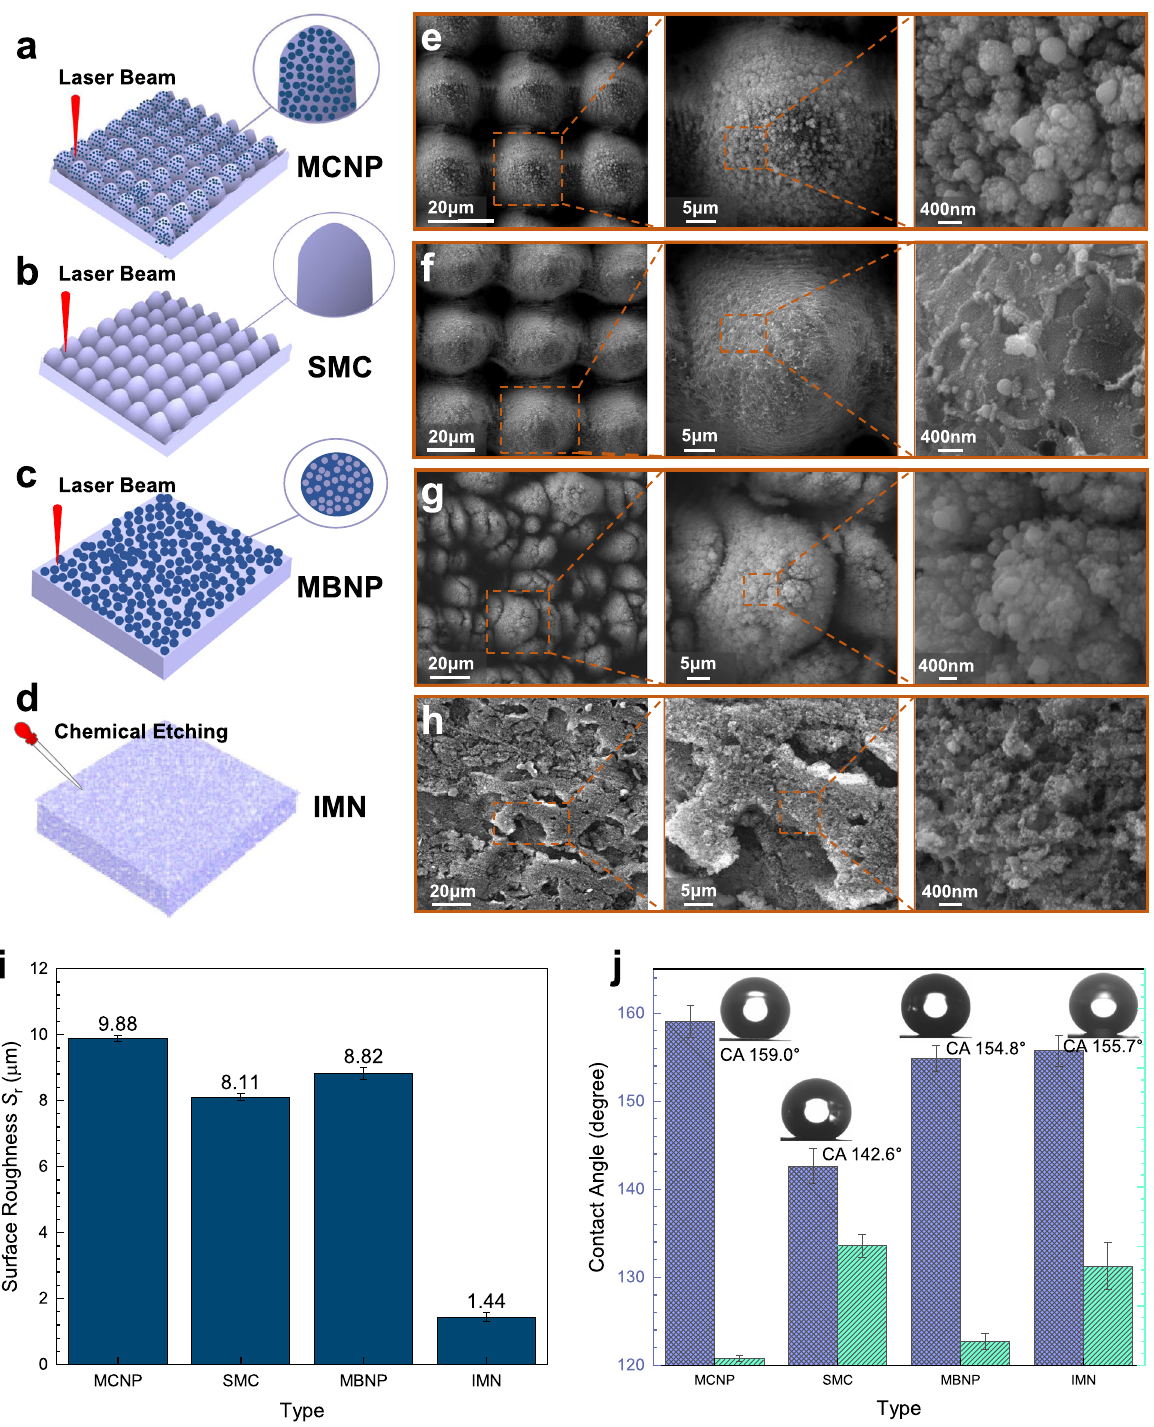
Fig. 1 Schematic illustration of fabrication strategies and the topologies of four types of micro-nanostructured surfaces. a Double-scale periodical microcones with dense nanoparticles (denoted as MCNP) by laser. b Single-scale periodical microcones (SMC) by laser. c Double-scale random microbumps with dense nanoparticles (MBNP) by laser. d Irregular micro-nanostructure by chemical etching (IMN). SEM images with different magni fi cations e of MCNP, f of SMC, g of MBNP, and h of IMN. Scale bars are marked. i Surface roughness of four surfaces. j Contact angles (CA) and sliding angles of four surfaces at room temperature (15 °C and a humidity of 20%). Contact angles of four surfaces are marked. Data are mean ± s.d. from at least three independent MCNP surface ( S r = 9.88 μ m) is slightly rougher than the MBNP ( S r = 8.82 μ m) and SMC ( S r = 8.11 μ m), and is much rougher than IMN ( S r = 1.44 μ m). More detailed processing information is given in Supplementary Table 1 and Supplementary Method 1.